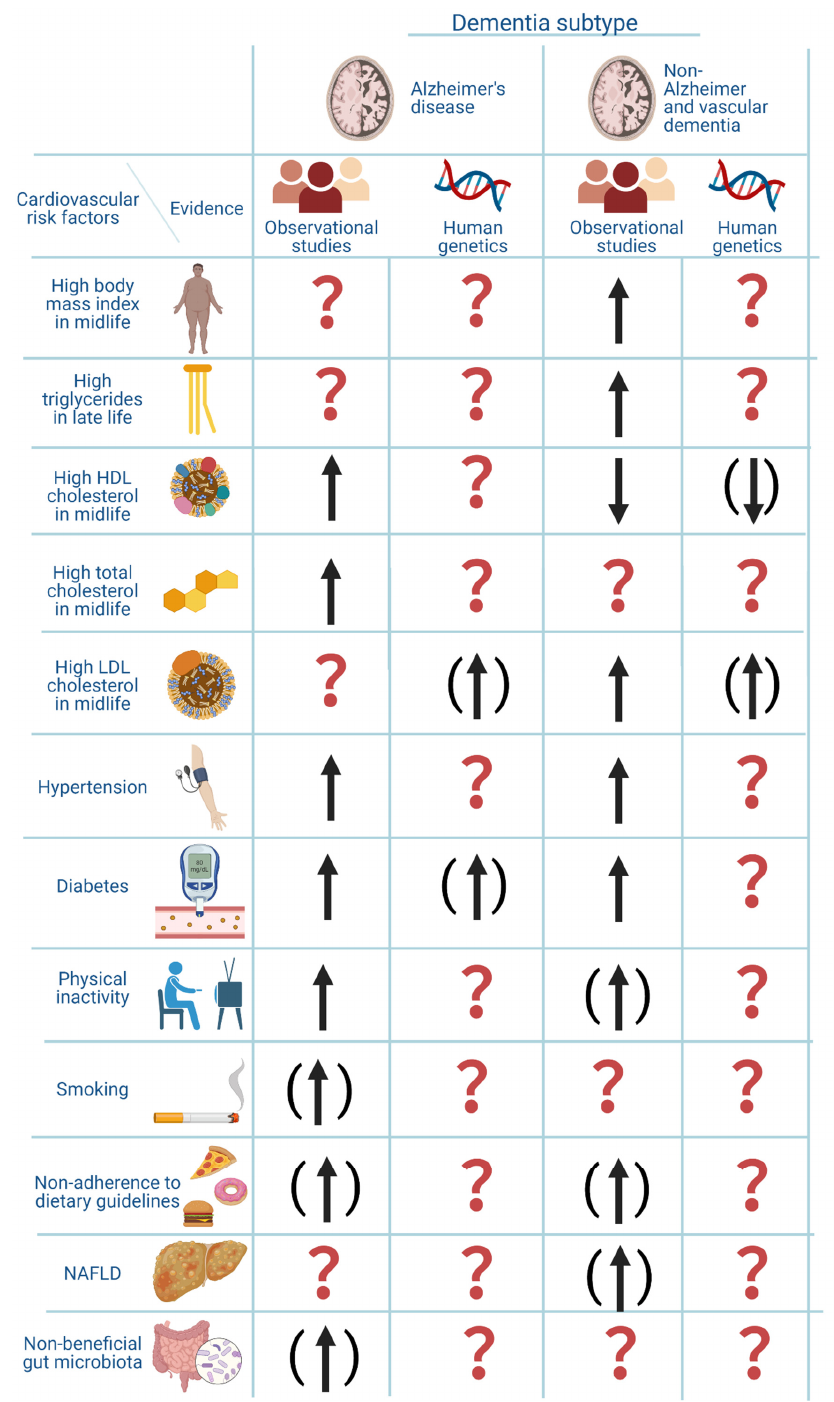
Figure 8. Overview of atherosclerotic cardiovascular risk factors and their association with risk of dementia . The figure is based on the current review of the literature. The arrows indicate the direction of the association. An arrow without parenthesis means moderate to good evidence. An arrow with parenthesis means weak evidence. A question mark means that the evidence is not available or very unclear. The genetic evidence for LDL cholesterol was based on the article by Benn et al. that investigated the association between low LDL cholesterol and dementia, and the association was assumed to be similar but in the opposite direction for high LDL cholesterol and risk of dementia. Created with